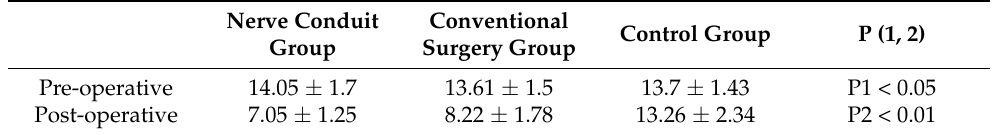
Table 6. Results of the 2-PD test in the three groups. Nerve Conduit Conventional Control Group P (1, 2) Group Surgery Group